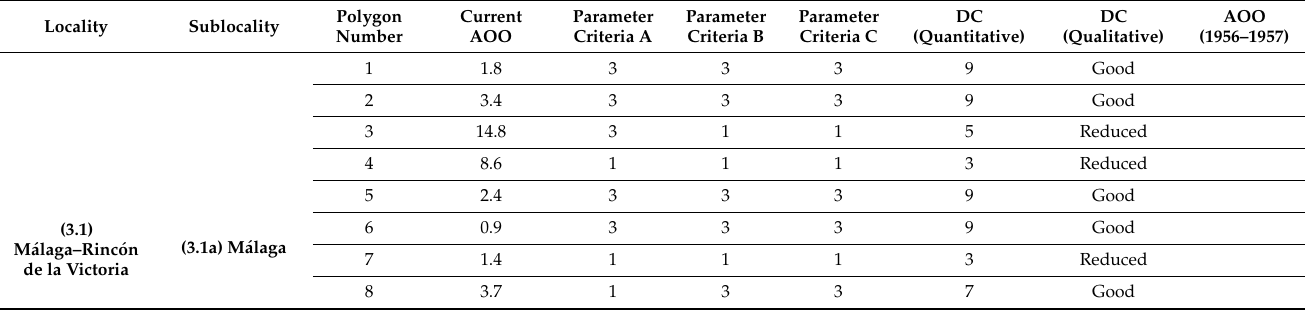
Table 2. Degree of conservation (DC) and area of occupancy (AOO, in hectares -ha-) of the 5220* HCI for the study area, which are indicated by the numbers of polygons for each locality/sublocality. The summary of the assessment of DC appears with the number of individuals of G . senegalensis subsp. europaea present in each polygon (parameter A); the percentage of the area occupied by the 5220* HCI in the total area of the polygon (parameter B); and the invasion degree of alien species and/or ruderal communities (parameter C). DC is expressed in quantitative and qualitative values and the average value for the whole locality/sublocality. AOO for the 1956–57 period is shown in